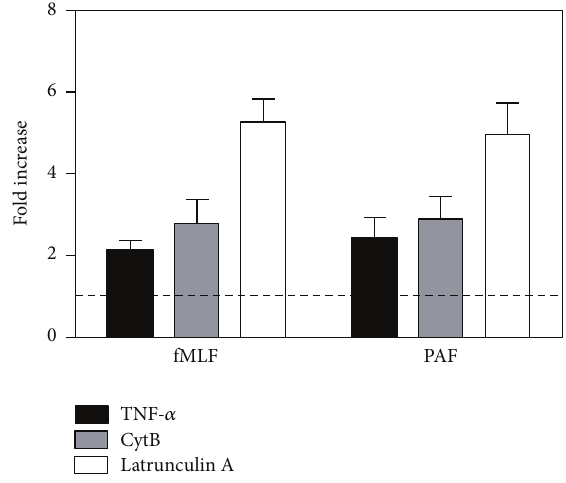
Figure 4: PAF triggers a rapid and WEB2086 sensitive release of superoxide anions from human neutrophils. Human neutrophils (10 5 cells) were incubated at 37 ∘ C for 5min in measuring vials containing isoluminol and HRP in the absence (control, solid line in the main figure) or presence of the PAFR antagonist WEB2086 (dashed line in the main figure). The cells were then activated with PAF (100nM, added at arrow), and the release of superoxide anions was recorded continuously. Inset: the kinetics of superoxide production induced by PAF (100nM; solid line) was compared to that induced by fMLF (100nM; dashed line), and the times required to reach the respective peak of the response are given. Data are derived from one representative experiment out of at least five. Abscissa: time of study (min); ordinate, superoxide production expressed as counts per minute × 10 6 (Mcpm; main figure) or normalized to compare the time courses (inset).